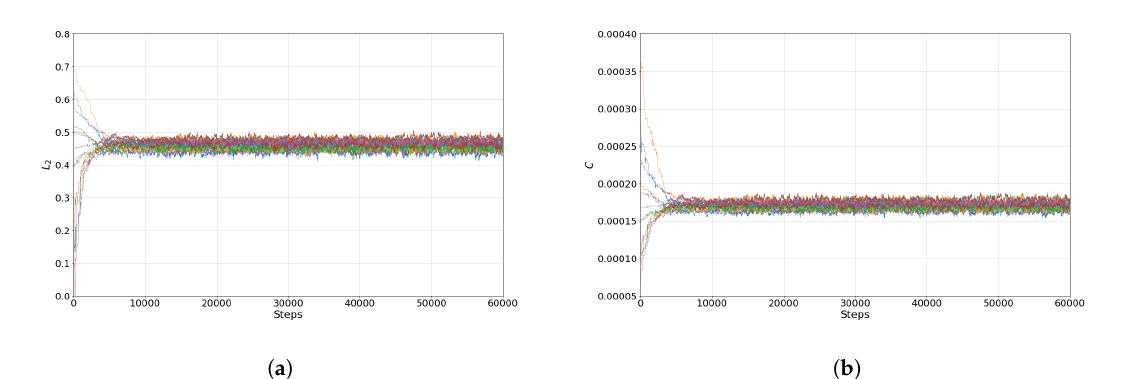
Figure 6. Gelman-Rubin test for Delta Gravity model. There are 16 chains with different priors. ( a ) All the chains converge to a L 2 ≈ 0.455. ( b ) All the chains converge to a C ≈